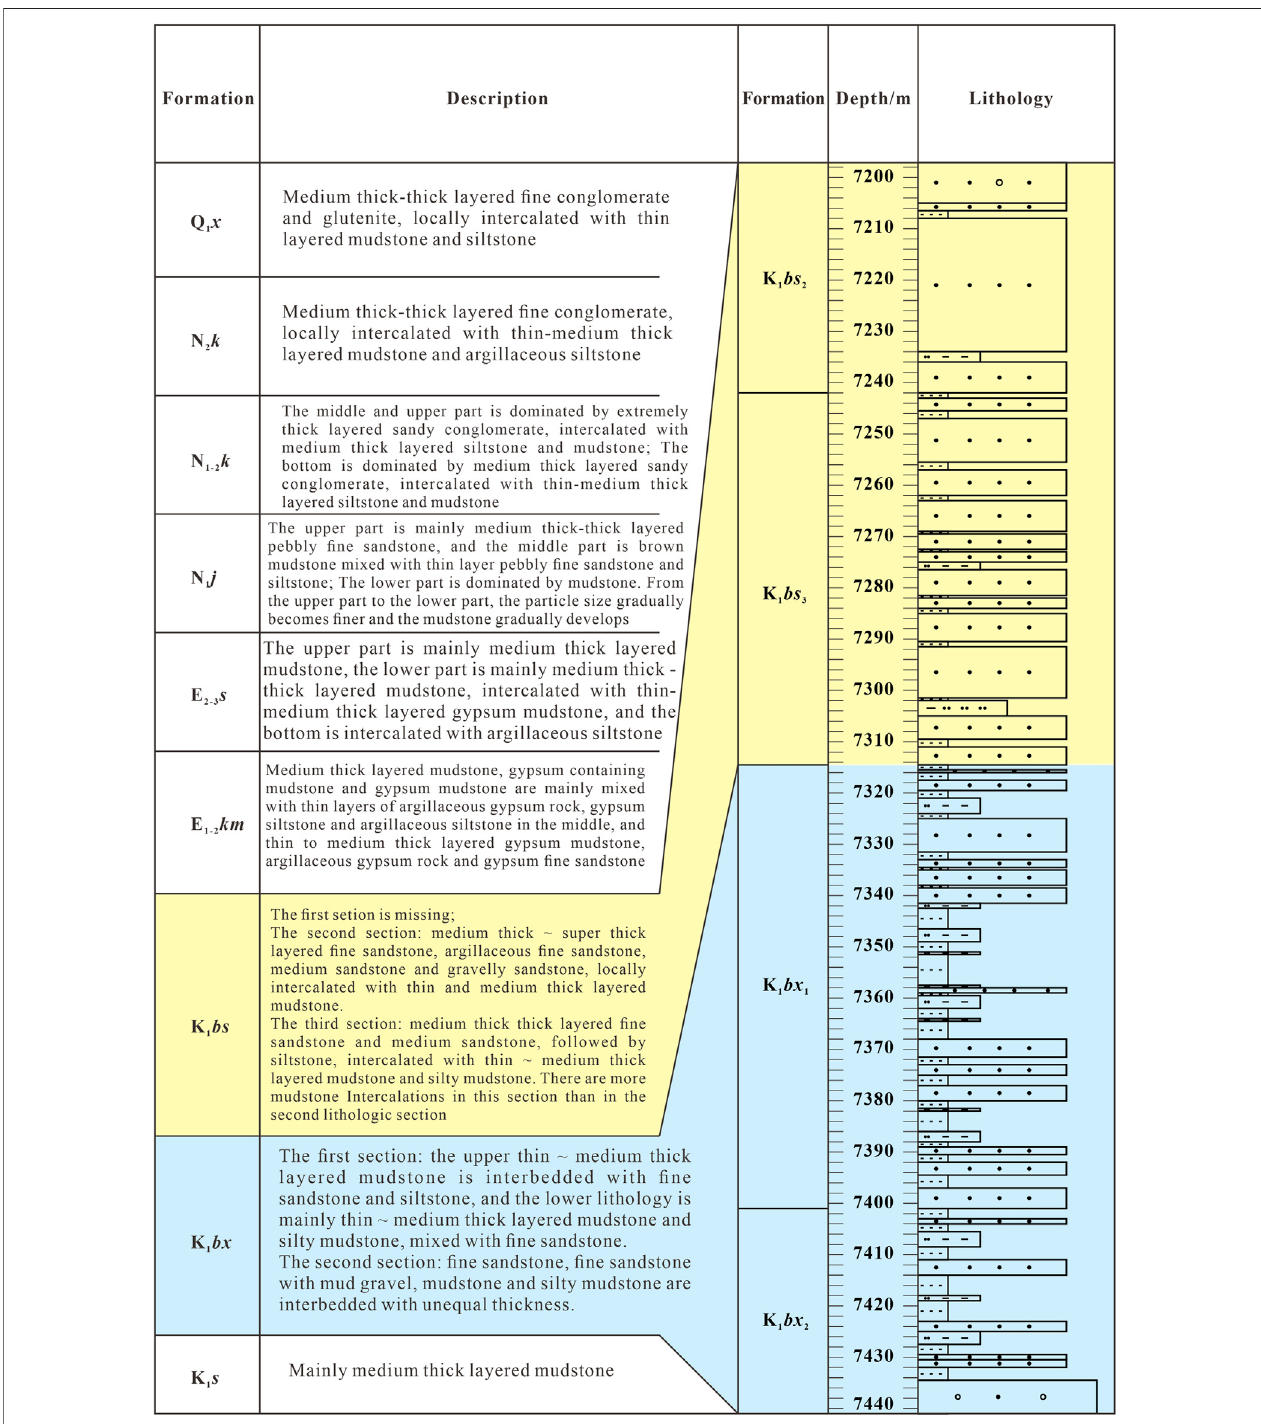
FIGURE 2 | Stratigraphic histogram and lithology description in the Bozi gas fi eld.